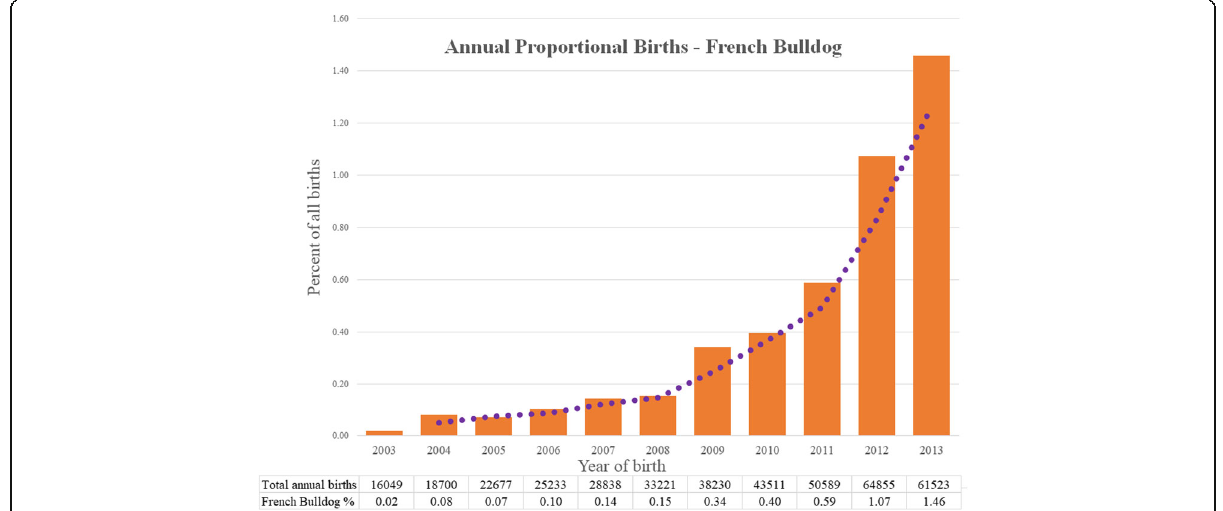
Fig. 1 Annual proportional birth rates (2003 – 2013) for French Bulldogs ( n =2228) among all dogs ( n =455,557) attending UK primary-care veterinary clinics participating in the VetCompass ™ Programme. A moving average trendline calculated from 2 periods is overlaid